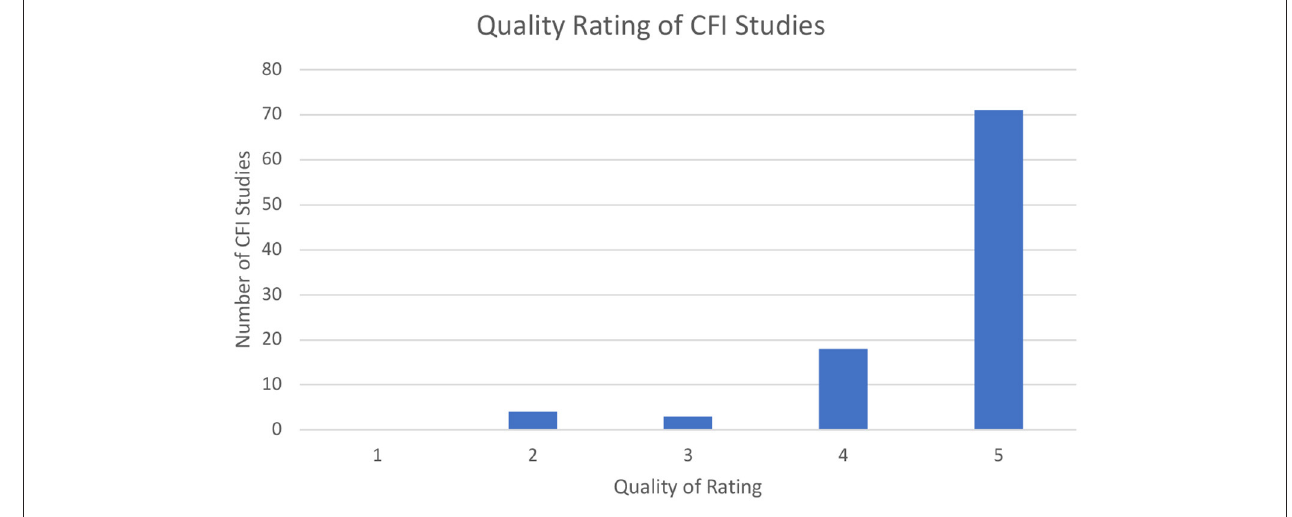
FIGURE 2 | Quality rating of CFI studies.